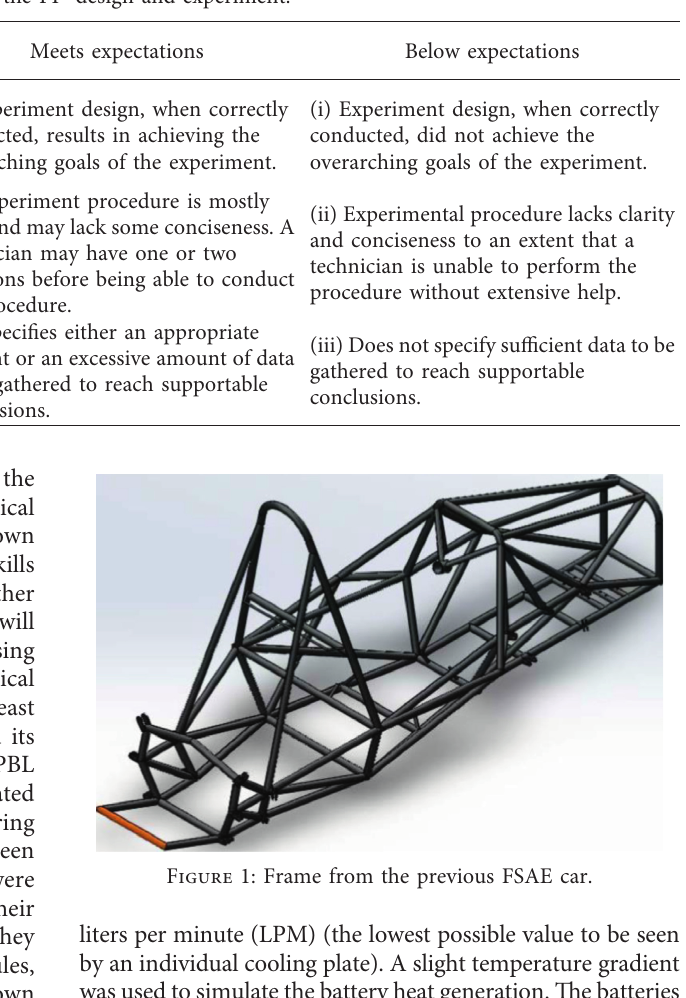
Table 2: Rubric for the PI “design and experiment.”